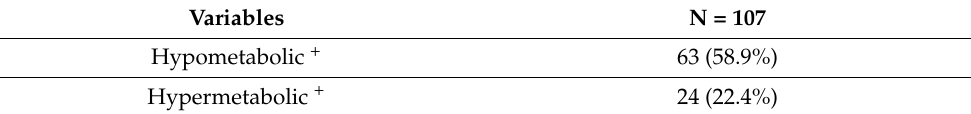
Table 3. REE VCO2 derived from an RQ of 0.80 had the lowest median difference and bias ( − 8.7 kcal/day), an accuracy of 57% (within 10% of REE IC values), and the highest dis- persion of values (CV 1427%). Equations using an RQ of 0.89 had the highest bias and significant median differences ( p < 0.001), while accuracy was lower than 50% for all equa- tions using an RQ of 0.85 or 0.89. The control equation using the individual RQ IC values presented the best accuracy (89.7%), but a significant median difference ( p < 0.001), CV of 266%, and a bias of − 38.48 (limits of agreement − 239.1; 162.2) kcal/day (Supplementary Materials, Figure